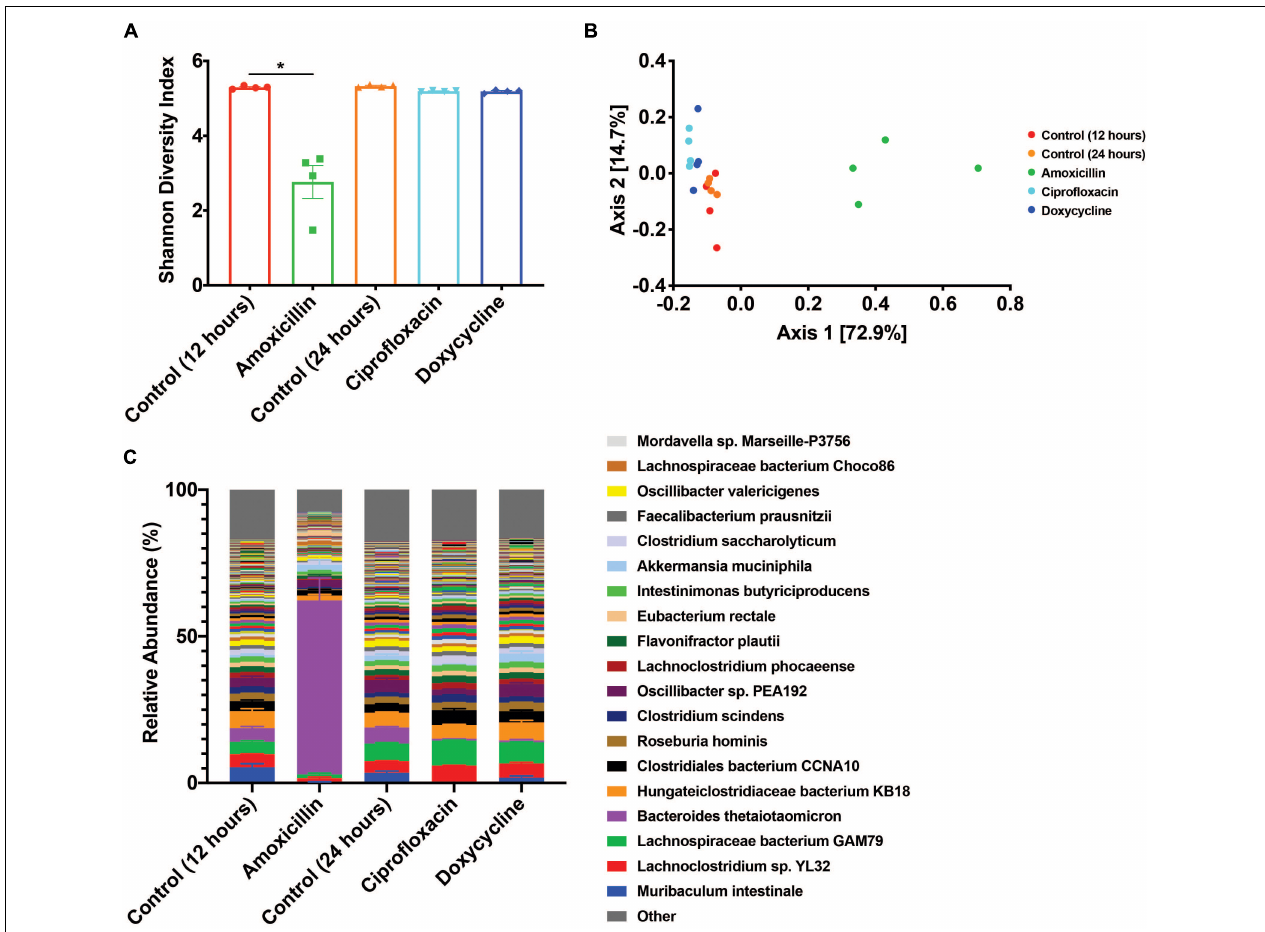
FIGURE 1 | Antibiotic treatment has variable impacts on the diversity and taxonomic structure of the microbiome. (A) Shannon diversity index displayed as mean ± SEM (* p < 0.05 Mann-Whitney U test, n = 4). (B) PCoA based on Bray-Curtis beta diversity. (C) Relative abundance of bacterial species displayed as mean ± SEM ( n = 4, top 250 most abundant species colored, full relative abundance table available in Supplementary Table S2